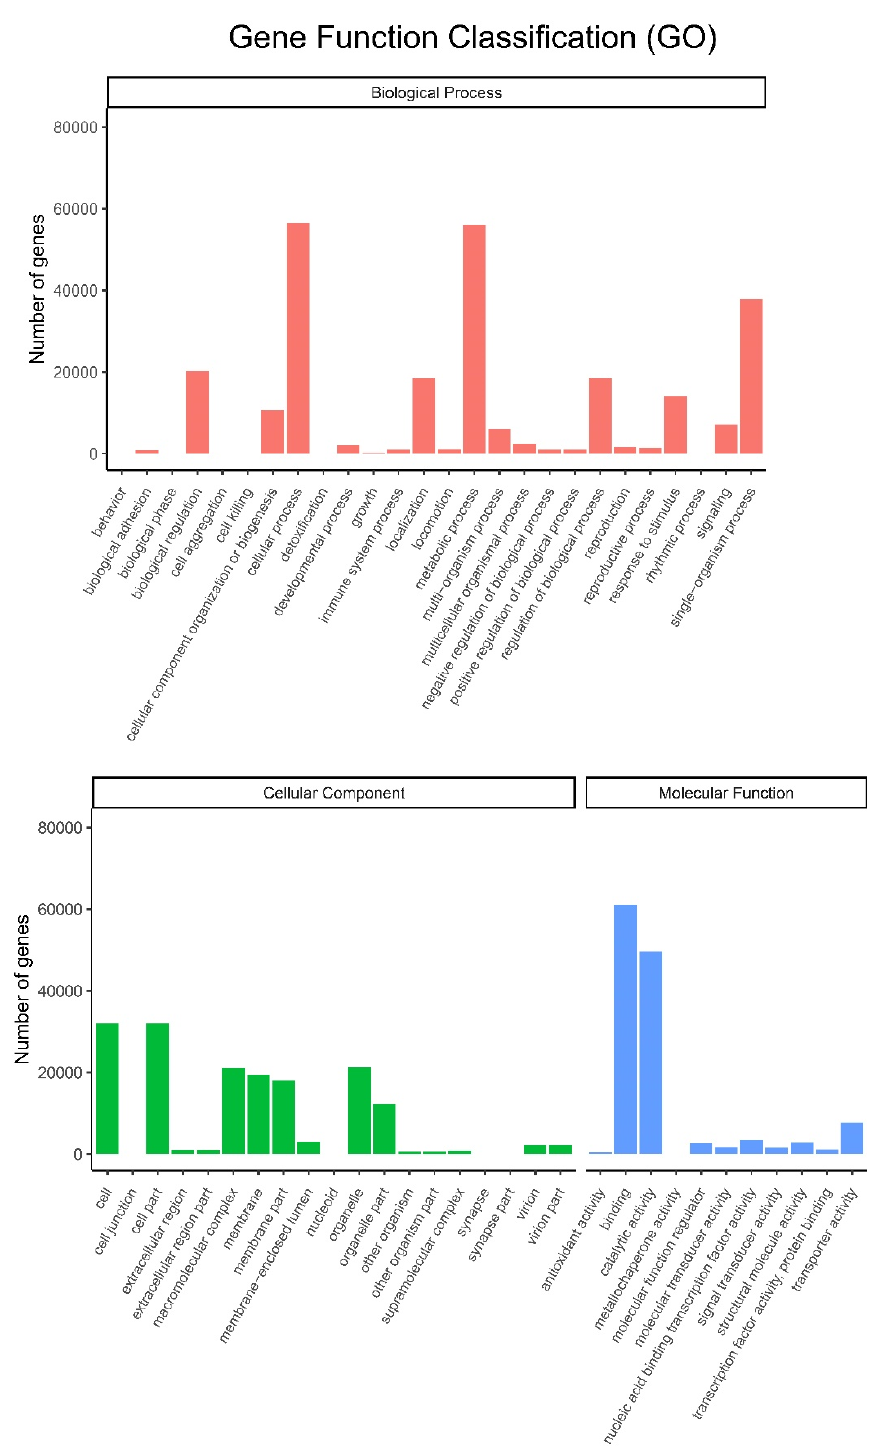
Figure 5. Histogram of GO classifications. Upper: biological process; Lower: cellular component and molecular function.